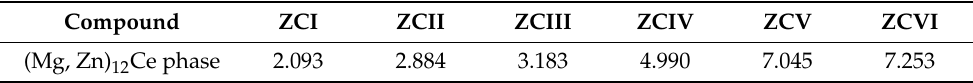
Figure 7. XRD spectrums of solid phases separated from homogeneous alloys. Table 4. The mass fraction of the (Mg, Zn) 12 Ce phase in the homogeneous alloys.